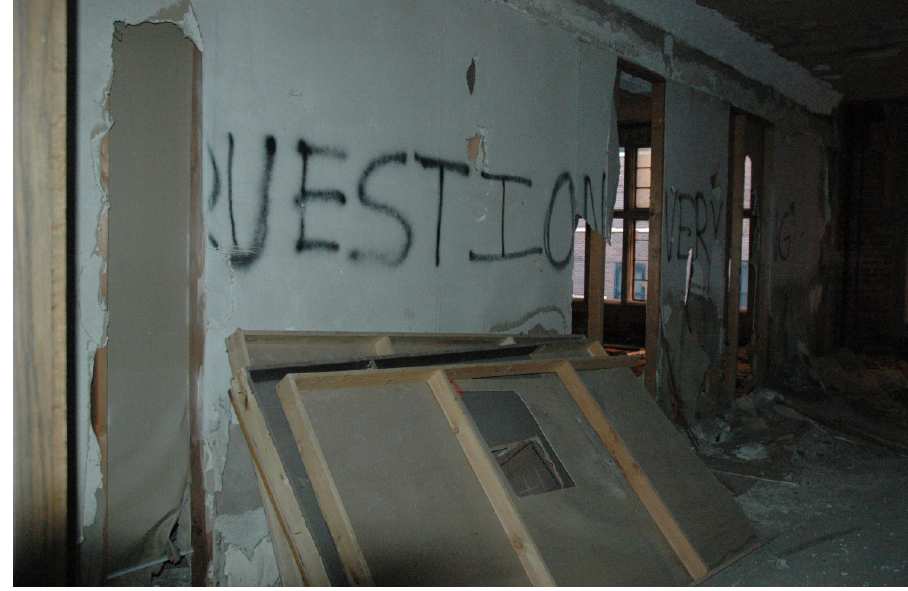
Figure 10. Photo of the wall in Gary Methodist Church in Gary, Indiana, shown in Figure 10 taken on a subsequent visit (Photo courtesy of Ball State University undergraduate architecture student Victor Pi ň